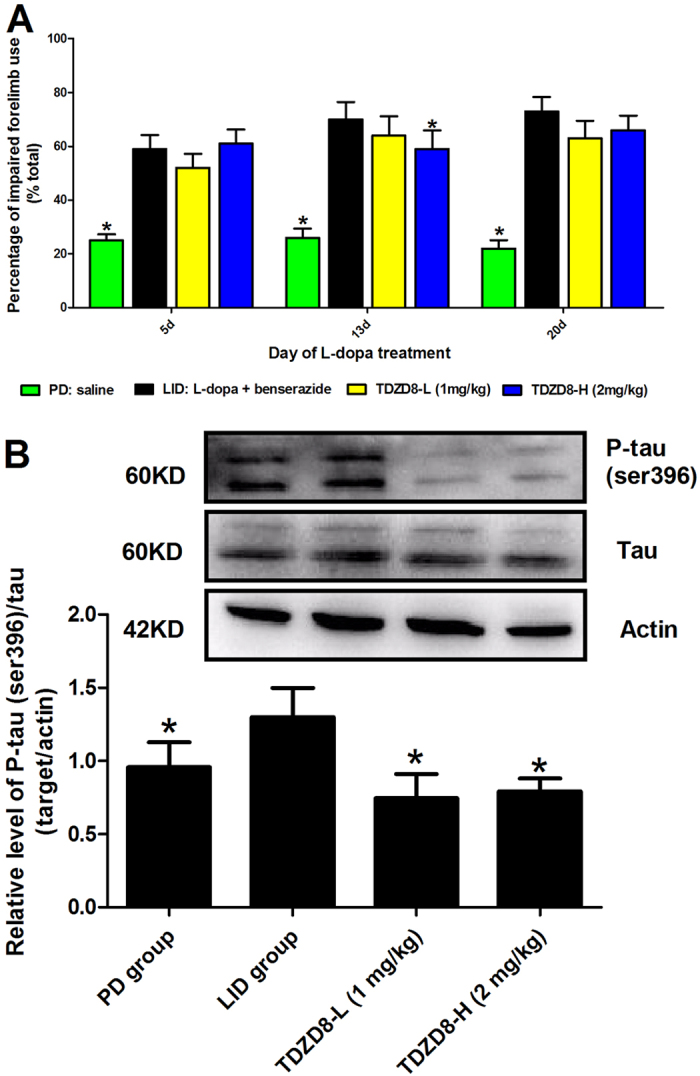
(A) Unilaterally 6-OHDA-lesioned rats were tested for the percentage of impaired forelimb use compared with the total numbers. Animals were injected with saline, L-dopa (25 mg/kg) plus benserazide (6.25 mg/kg), TDZD8-L (1 mg/kg) or TDZD8-H (2 mg/kg). Motor effects of TDZD8 in 6-OHDA-lesioned animals showed the chronic administration of TDZD8 could significantly improve parkinsonion disability score. Experiment consisted of three different sessions, namely 5d, 13d and 20d in the treatment period. Data are presented as mean ± SD. *p < 0.05 vs LID group, n = 8 per group; (B) Phosphorylated levels of tau (ser396) induced by L-dopa administration in 6-OHDA-lesioned animals was analyzed by Western blot in striatal samples. TDZD8 prevented increased level of p-tau and total tau after pulsatile L-dopa treatment. They were assessed in extracts from sham or 6-OHDA-lesioned rats treated with vehicle, pulsatile L-dopa plus benserazide or TDZD8-L (1 mg/kg) and TDZD8-H (2 mg/kg). The data represent the mean of relative optical density ± SD. *p < 0.05 vs LID group (one-way ANOVA, n = 4).